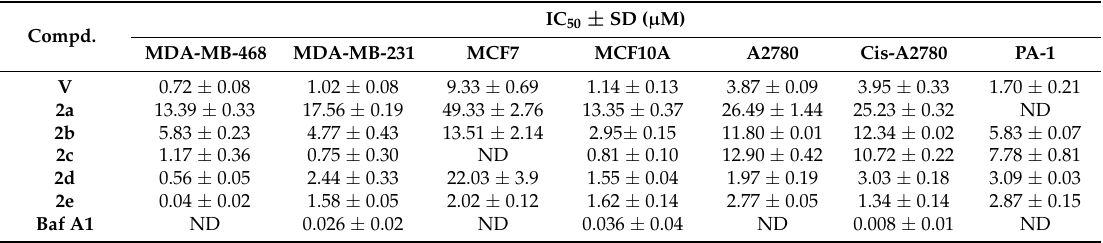
Table 1. Half maximal inhibitory concentration of novel bisbenzimidazole analogs ( 2a – e ). Compd.